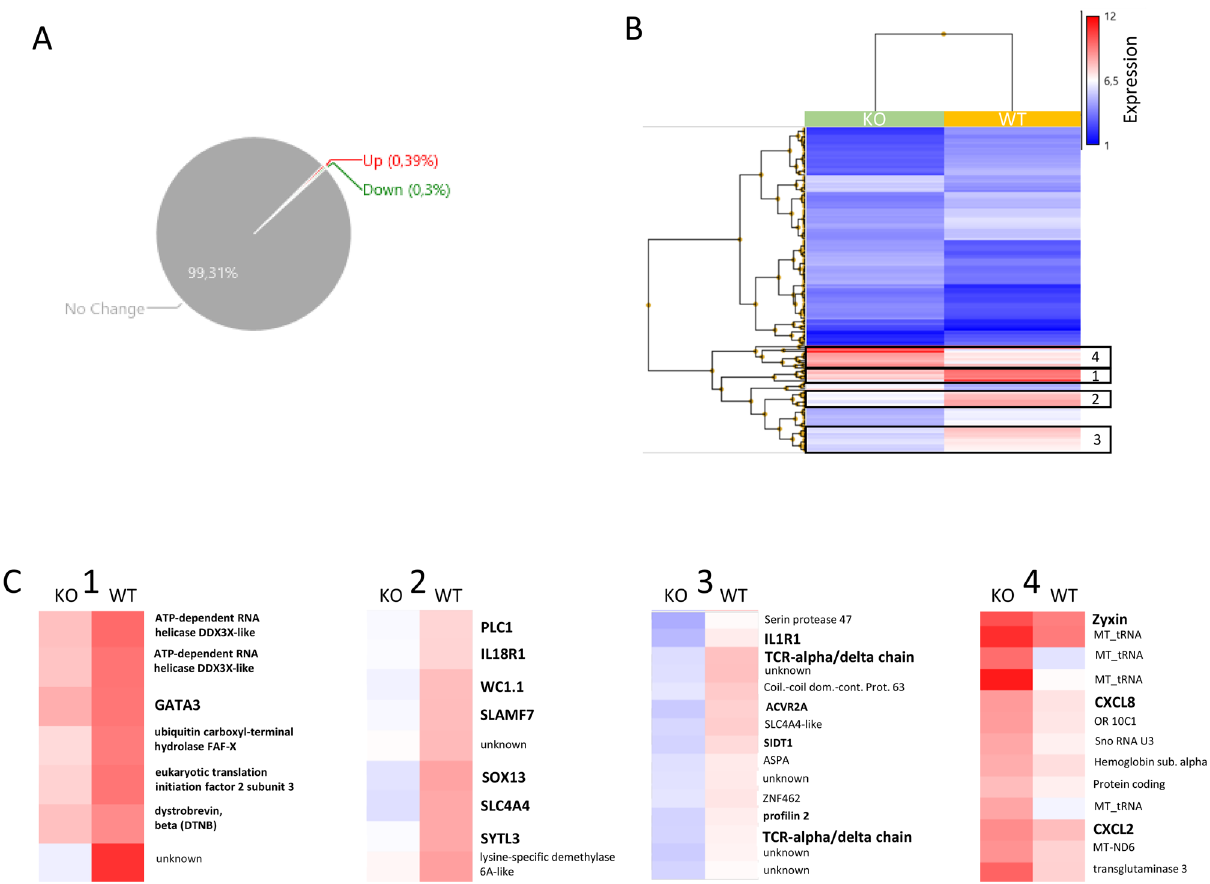
Figure 7. Transcriptional changes in PBMC of TRDC-knockout pig refelect the loss of γδ T cells. ( A ) Only 0.7% of genes were regulated more than twofold in PBMC of TRDC-knockout pigs. ( B ) Using hirachical clustering up-regulated and down-regulated genes were sorted acording to the expression levels. ( C ) down- regulated (1,2,3) and upregulated (4) genes from the hirachical clustering ( B ) were characterized in more detail. (1) all annotated genes of this cluster were expressed preferentialy by T cells. GATA3 is highly expressed by γδ T cells. (2) Cluster 2 contains genes like WC1.1 and SOX13 which are preferentially expressed by γδ T cells to a various degree. (3) T cell receptor genes were found in cluster 3. In addition, IL-1R (3) and IL-18R (2) were downregulated in PBMC of TRDC-knockout pigs. (4) Genes which were upregulated contain genes which were preferentially expressed by granulocytes and monocytes in human PBMC like Zyxin, CXCL8 and